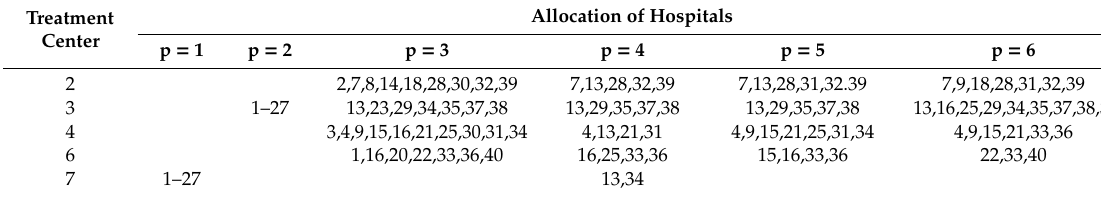
Table 8. Allocation of medical waste from di ff erent hospitals in each period.